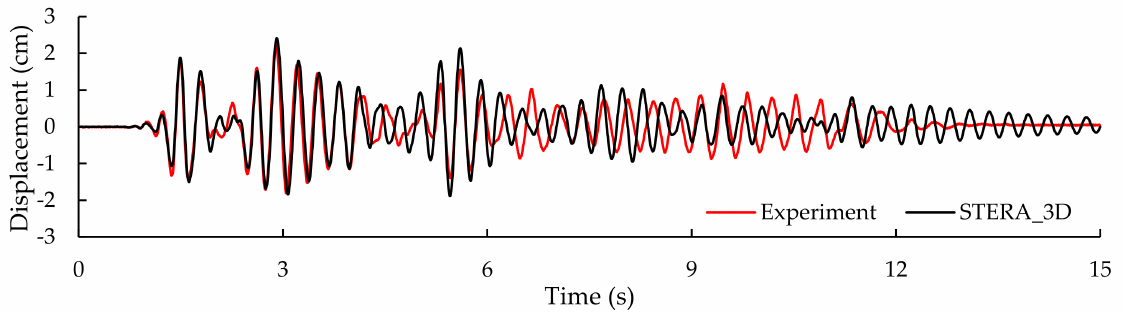
Figure 8. Roof displacement history responses of experiment of towered setback structure compared with